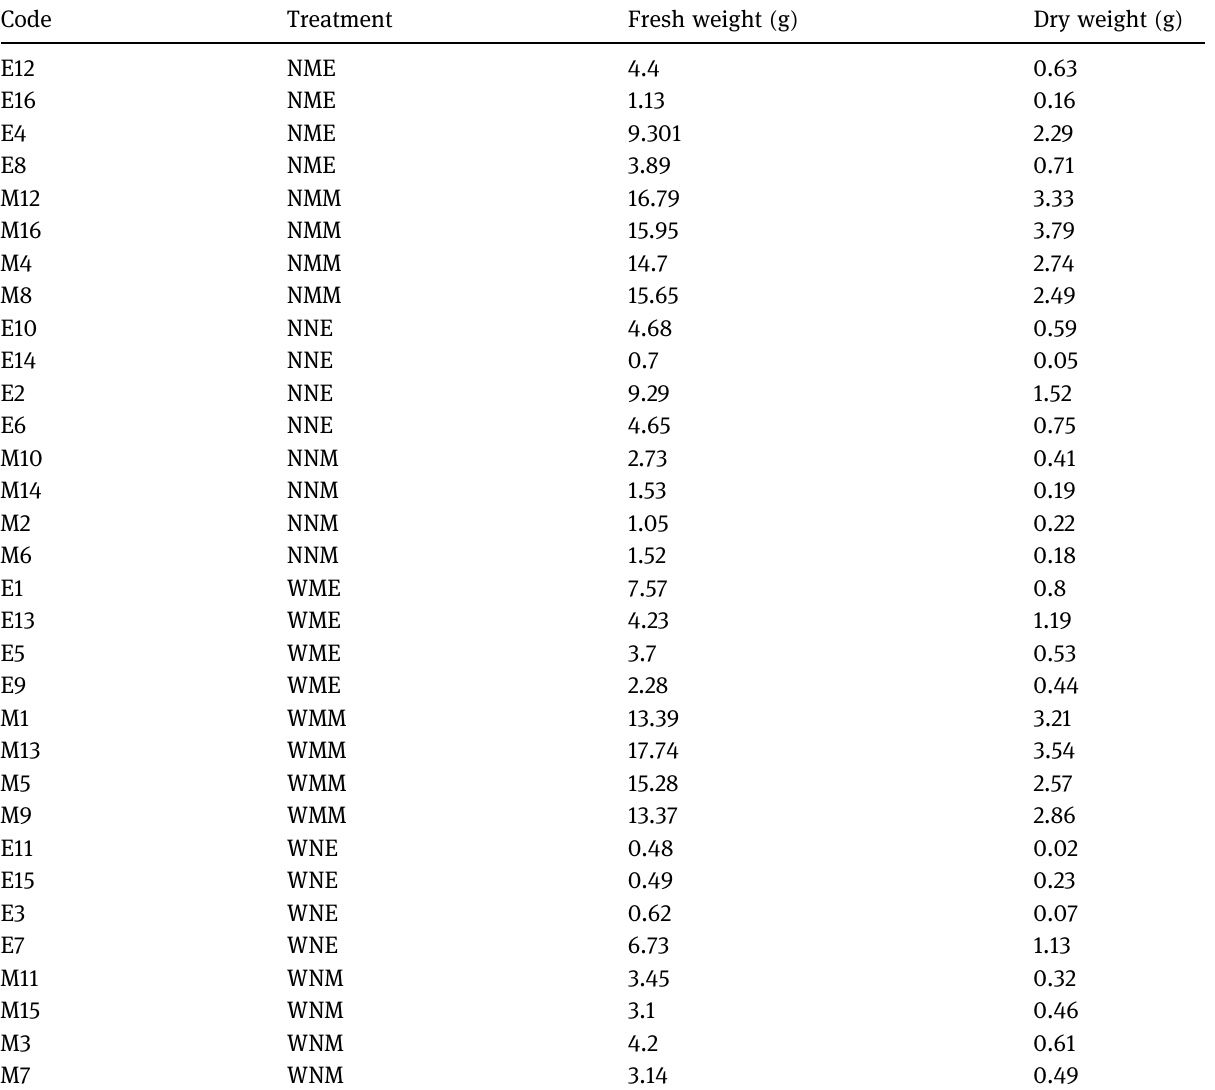
Table 1: Fresh and dry weights of the